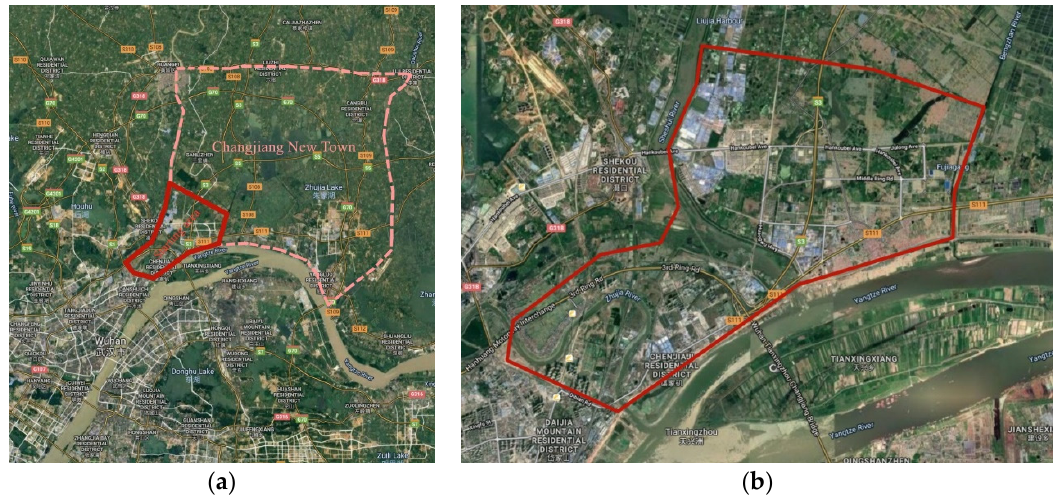
Figure 1. ( a ) Planning study area of Wuhan Changjiang New Town. ( b ) The starting area of Wuhan Changjiang New Town. Changjiang New